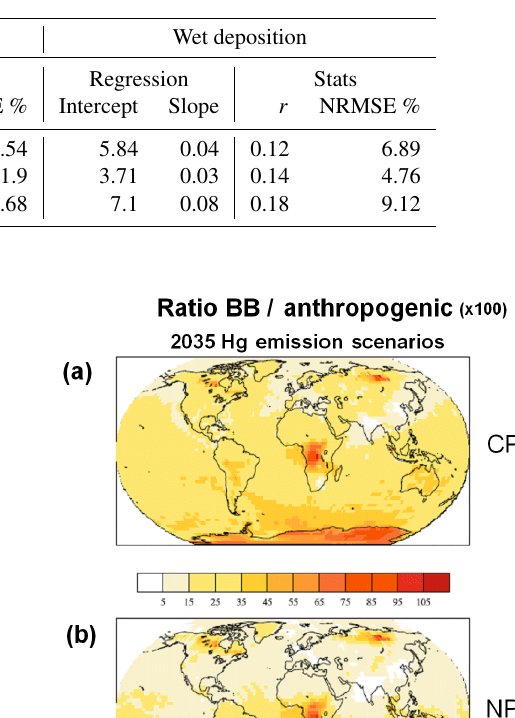
Table 6. Comparison of the results of BASE and Br simulations including all emissions sources with observations from measurement networks for 2013.